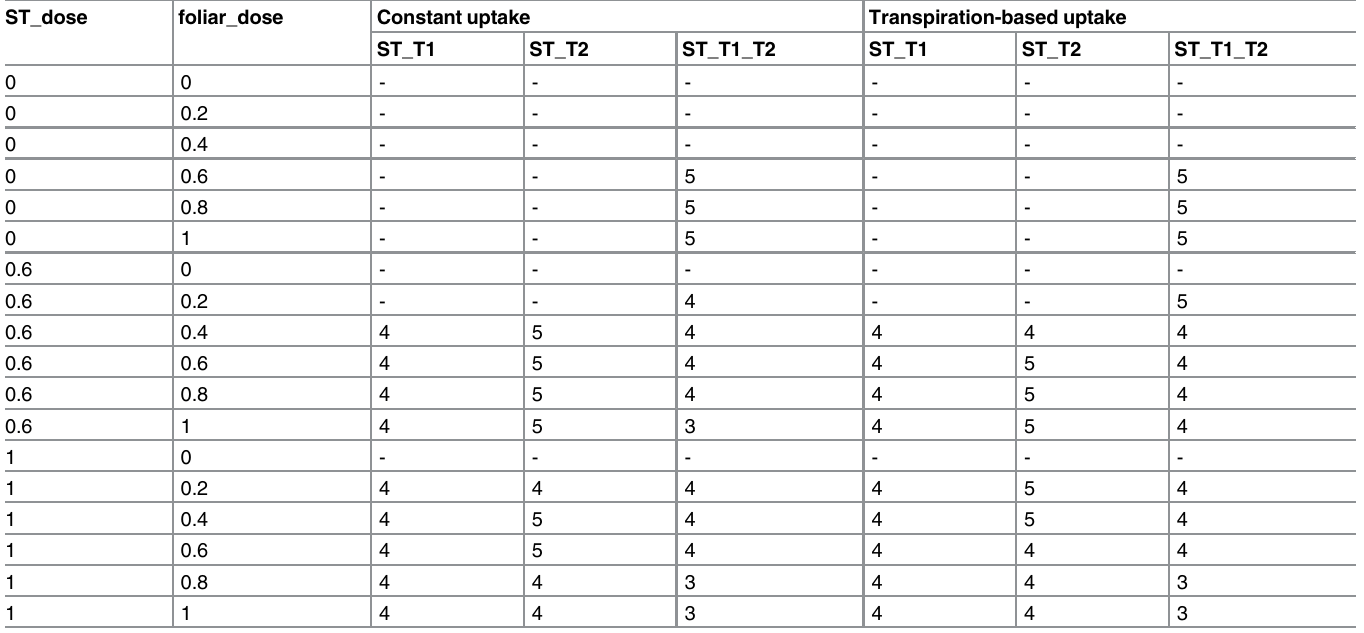
Table 4. Effective lives for the constant versus transpiration-based seed treatment uptake